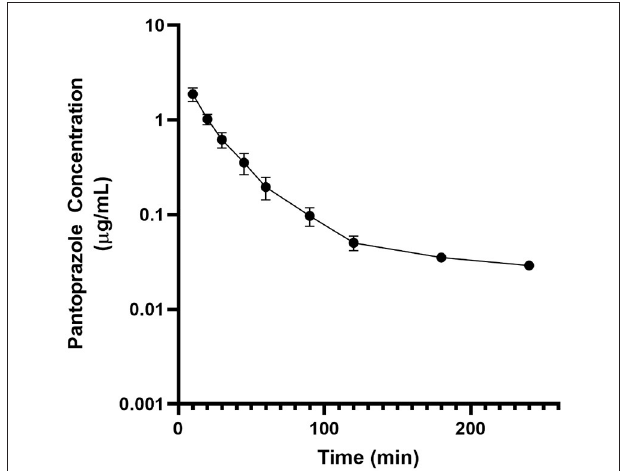
FIGURE 1 | Mean plasma pantoprazole concentration (logarithmic scale) vs. time (hr) profiles for adult goats ( n = 6) following intravenous (IV) single dose